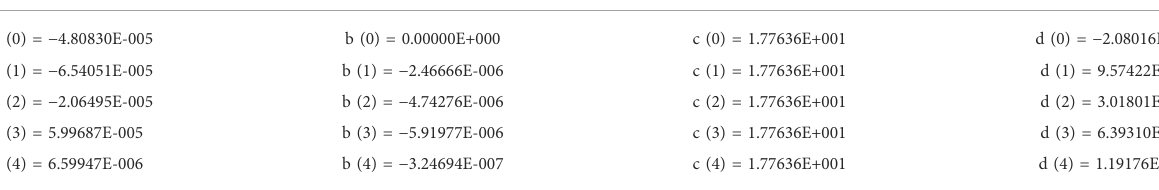
TABLE 6 EMIT Formula for SRL concentration calculation.